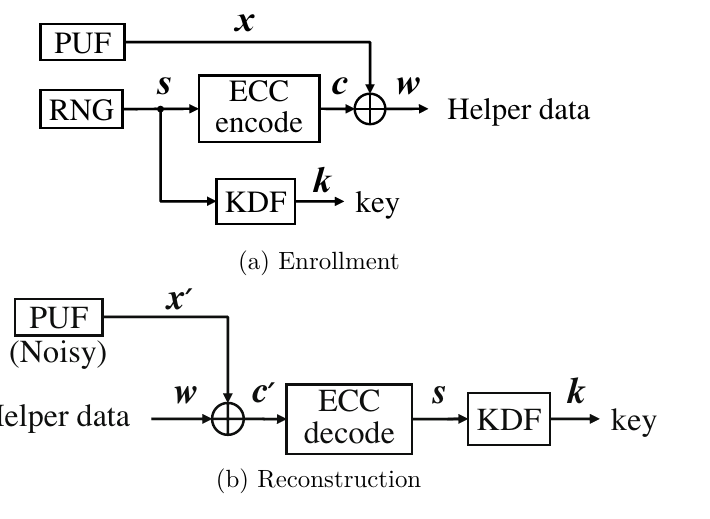
Figure 3: Block diagram of